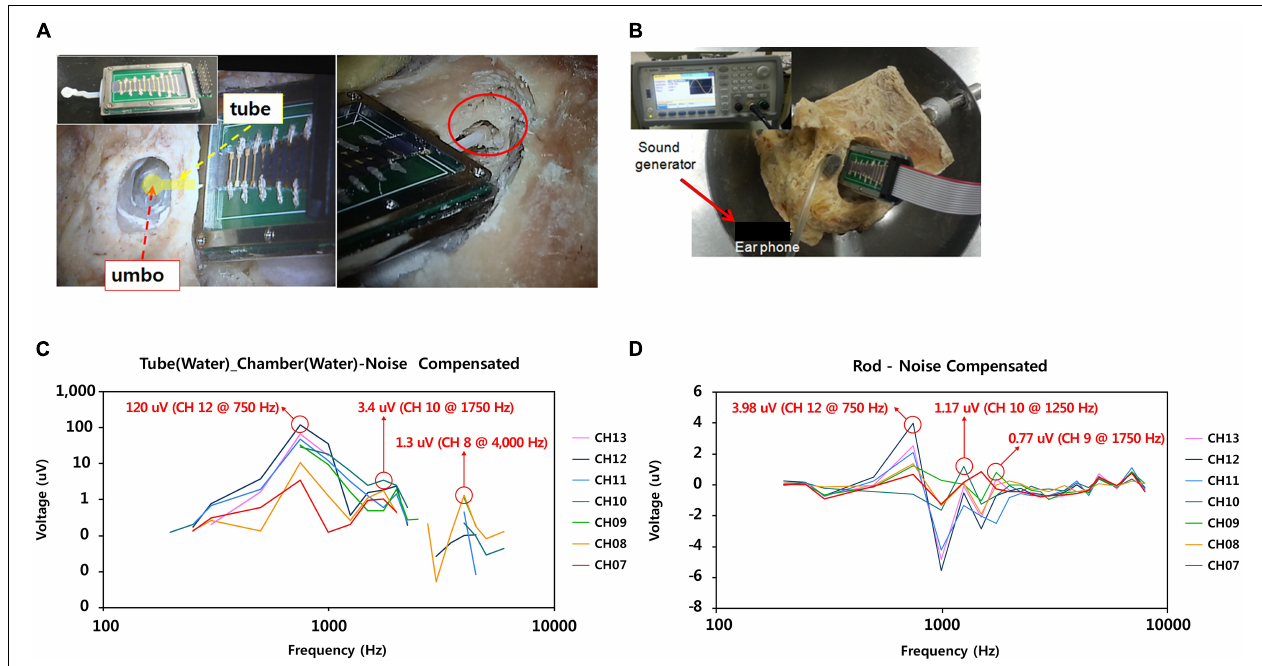
FIGURE 5 | Measurement of electrical output from the ABM with tube-type connector and rod type connector coupled to the ossicles in the cadaveric temporal bone. (A) Tube type connector coupled to the umbo (left); Rod type connector coupled with the malleus head (right), (B) The process of measuring the electrical output from the ABM package with the connector coupled with the ossicles after applying the sound pressure to the eardrum with sound generator. (C) Electrical output from the ABM coupled with tube type connector. (D) Electrical output from the ABM coupled with rod type